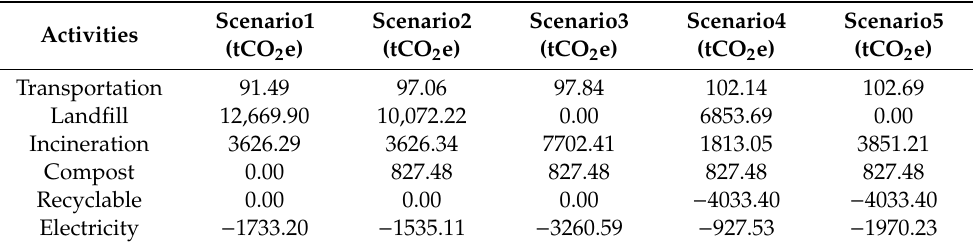
Figure 7. GHG emissions quantity in five scenarios. Table 9. GHG emissions quantity in five scenarios.